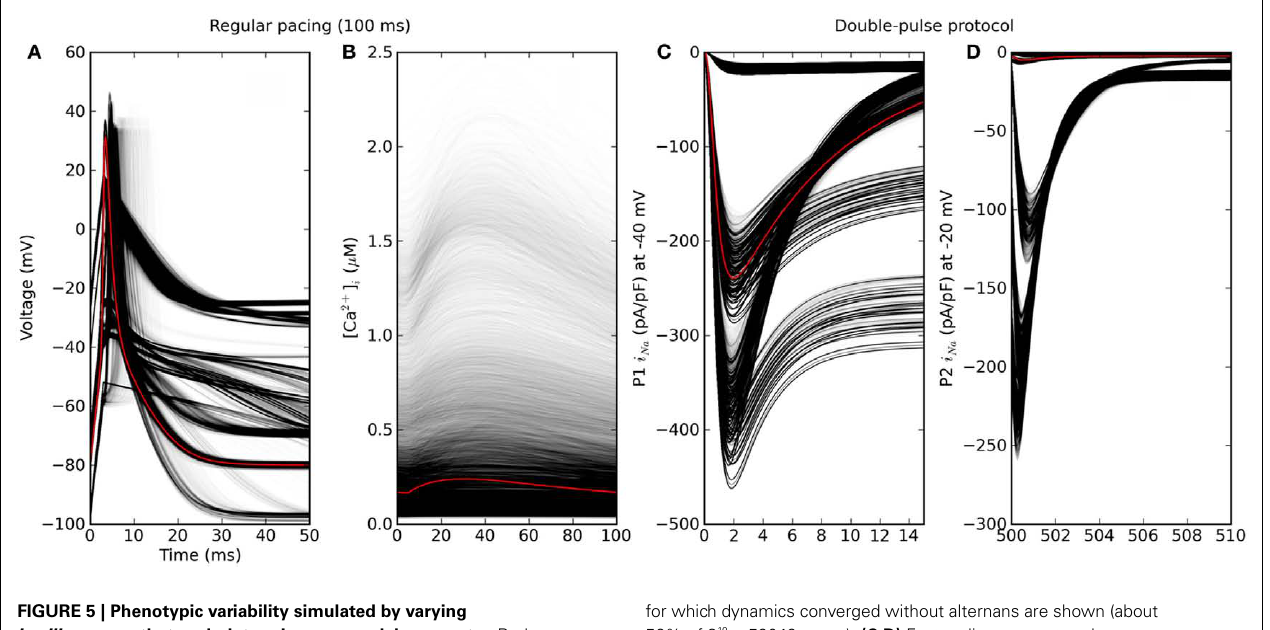
FIGURE 5 | Phenotypic variability simulated by varying in silico genes that each determine one model parameter. Red is the baseline genotype. (A) Action potential and (B) calcium transient under regular pacing at 100ms intervals. Only genotypes